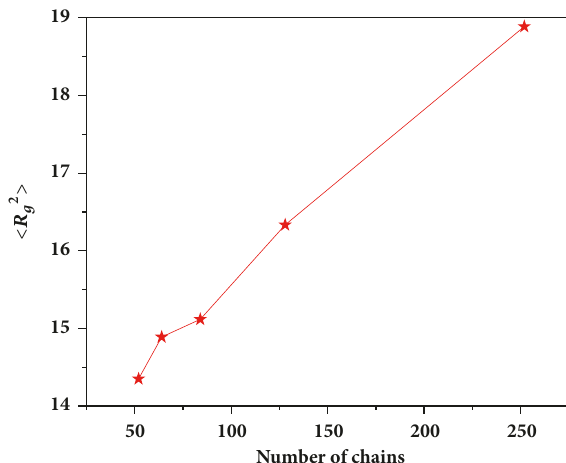
Grafted system with 52 chains (5) Grafted system with 64 chains (4) Grafted system with 84 chains (3) Grafted system with 128 chains (2) Grafted system with 252 chains (1) Figure 5: Segmentdensity near thenanorod for the grafted polymer systems with 52, 64, 84, 128, and 252 polymer chains, respectively.